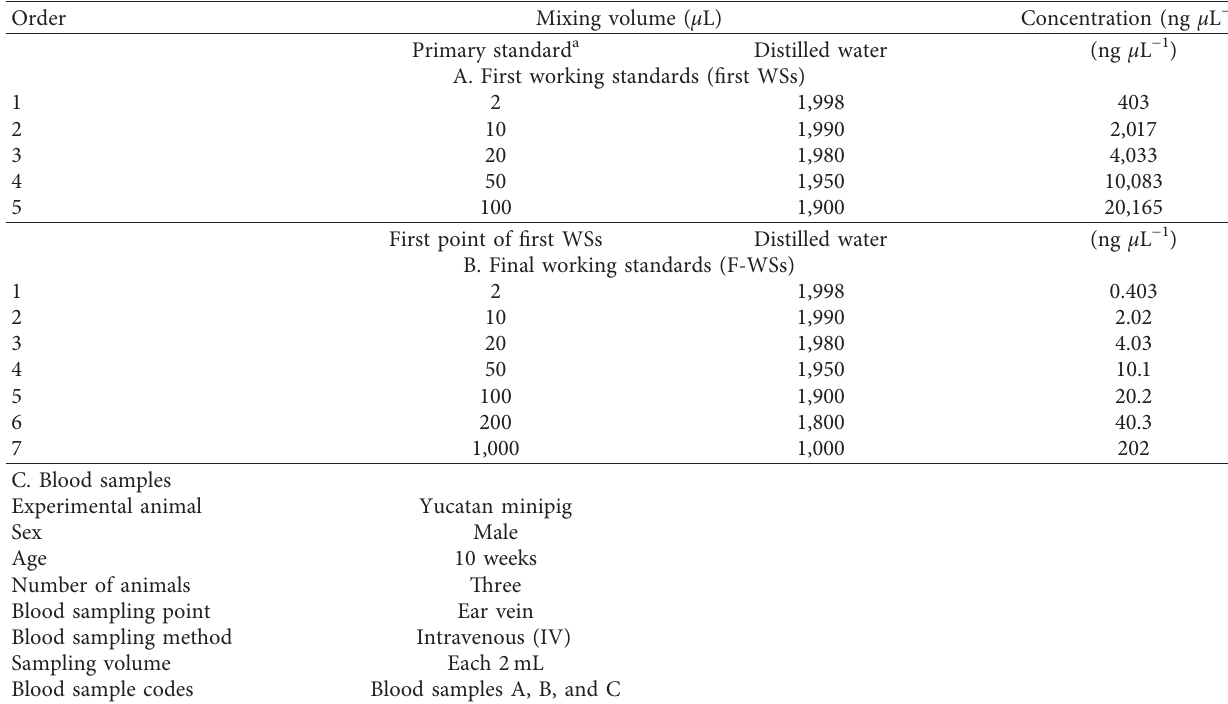
Table 1: Preparation of FA standards and blood